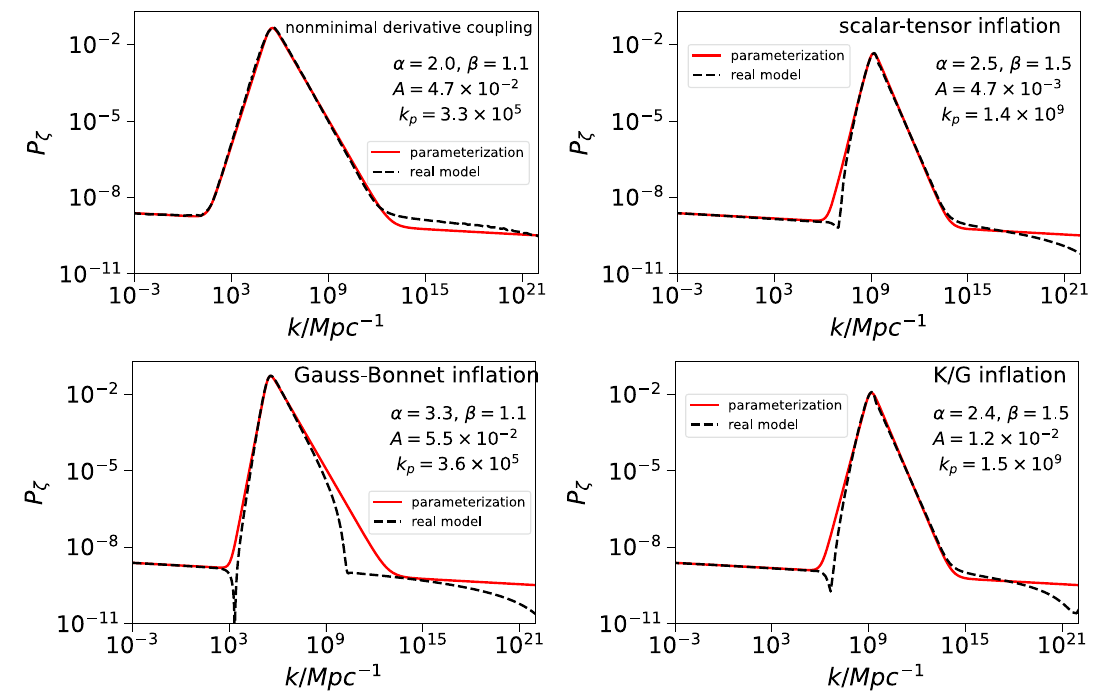
Fig. 1 The difference between the power spectra from real inflation models (denoted by black dashed lines) and parameterization (32) (marked by solid red lines). The left upper panel, right upper panel, left lower panel, and right lower panel are the power spectra from infla-